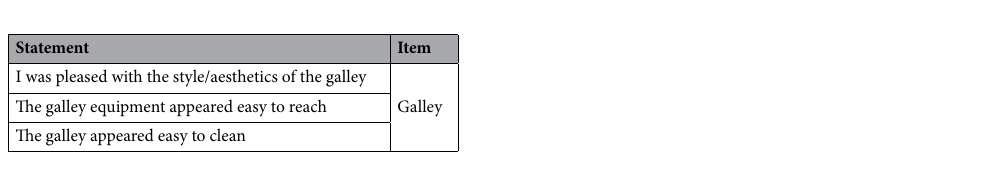
Table 4. Galley scenario questionnaire.